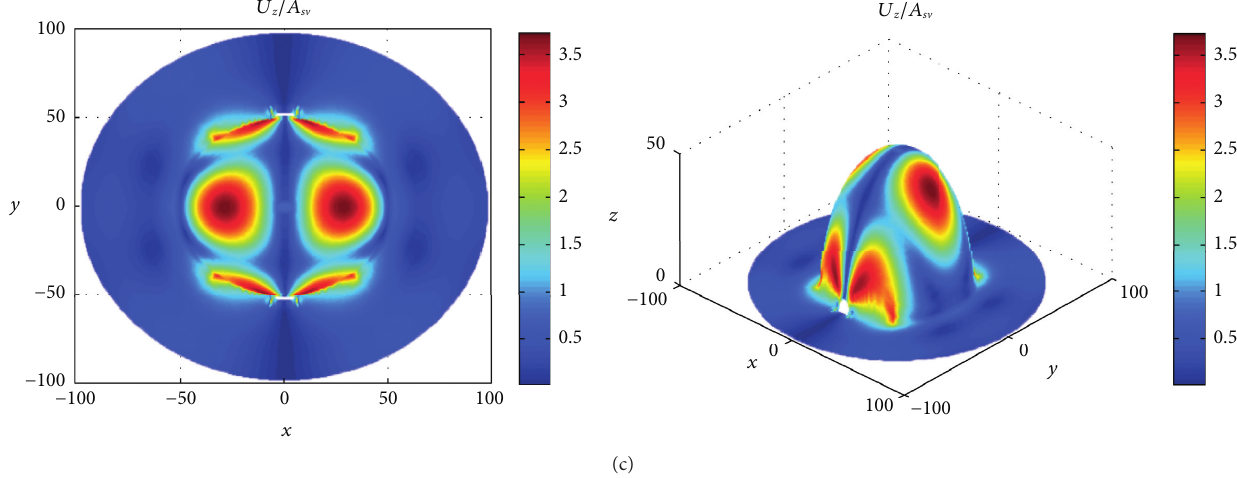
Figure 12: Surface displacement amplitude of the 3D tunnel mountain under the incident SV wave ( η � 1 . 0 , α � 0 ° ): (a) surface dis- placement amplitude in x direction; (b) surface displacement amplitude in y direction; (c) surface displacement amplitude in z